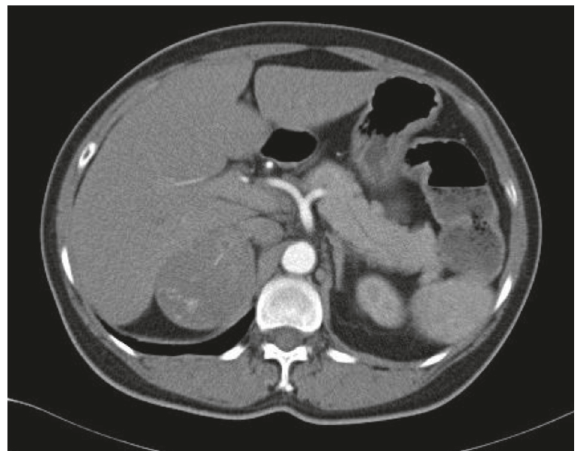
Figure 1: CT abdomen of Patient A on 9 August 2012. A 6.4 × 5.2 × 5.8cm heterogeneously enhancing mass in the right adrenal gland with pre-contrast HU 35.4 (red